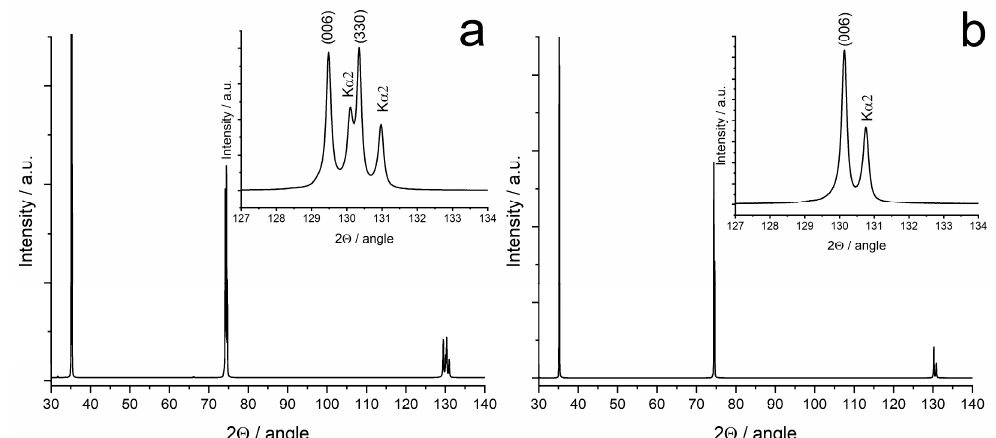
Figure 2. Diffractograms of 8Sc1GdSZ ( a ) and 10Sc1GdSZ ( b ) crystals. Table 2. Lattice parameters of the tetragonal phase of crystals containing 8 mol% Sc 2 O 3 before and after annealing.